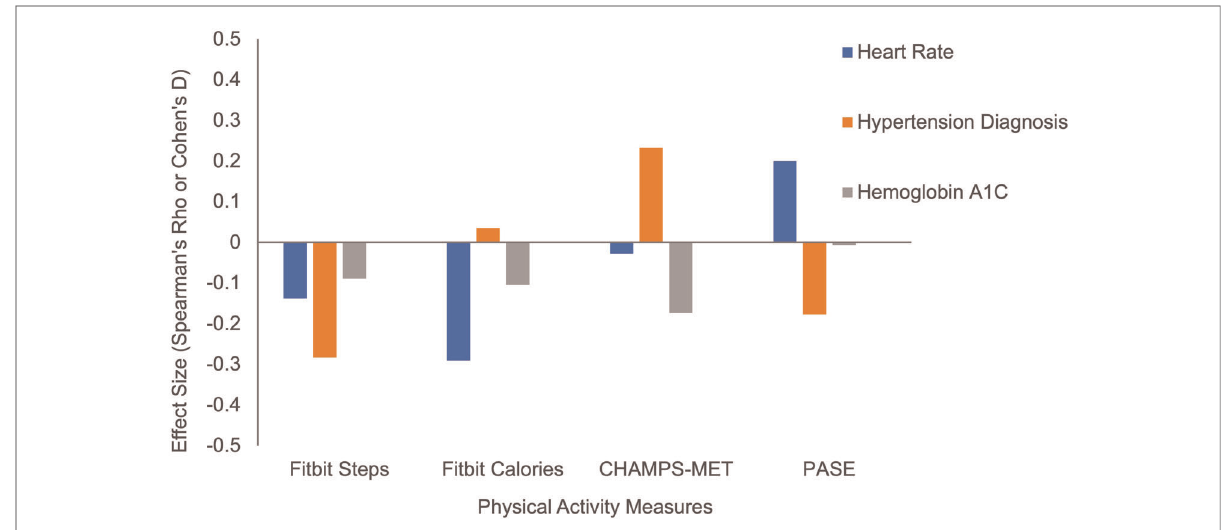
FIGURE 2 Physical activity measures with cardiometabolic outcomes. Note. *Statistically signi fi cant at p <0.05.